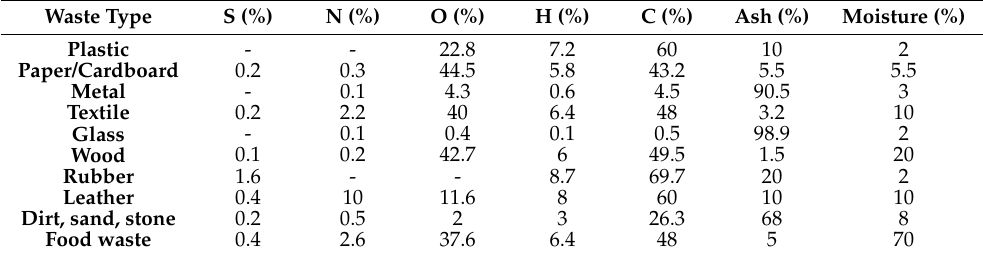
Table 11. The common data for the ultimate analysis of MSW and MCWB% [51].